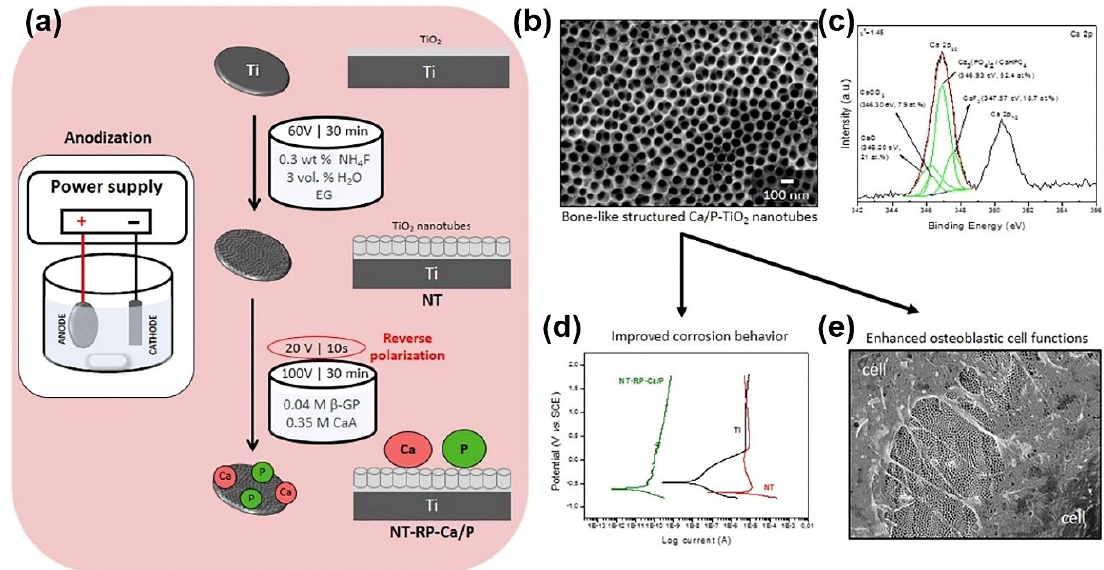
Figure 8. ( a ) Schematics during anodization; ( b ) FESEM micrographs showing the morphology of the highly ordered TiO 2 nanotubes present on NT-Ca / P; ( c ) high resolution XPS spectra of deconvoluted Ca 2p; ( d ) potentiodynamic polarization curves of Ti, NT, NT-Ca / P, and NT-RP-Ca / P samples immersed at 37 ◦ C; ( e ) FESEM micrographs of MG-63 cells cultured on NT-RP-Ca / P surfaces after one day of incubation. (Reproduced with permission from [198]. Copyright Elsevier, 2016).